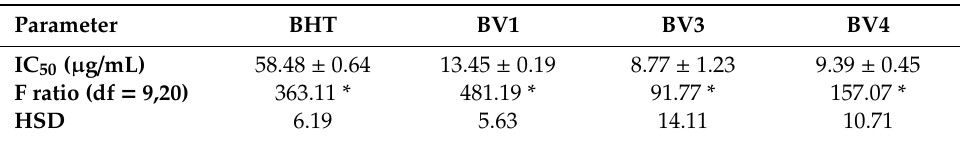
Figure 4. The ABTS radical scavenging activities of standard reference compound BHT and compounds isolated from Bauhinia variegata L. stem bark. BHT = butylated hydroxytoluene (standard reference compound); BV1 = kaempferol; BV3 = protocatechuic acid methyl ester; BV4 = protocatechuic acid. Table 5. IC 50 , one-way ANOVA F-ratio and HSD values of BHT and compounds isolated from Bauhinia variegata L. stem bark in ABTS radical scavenging